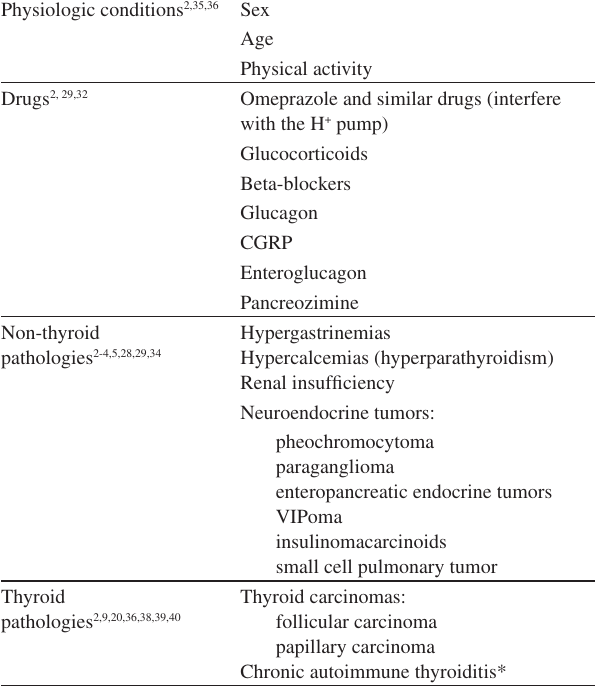
Table 1- Hypercalcitoninemia in non-medullary thyroid carcinoma conditions